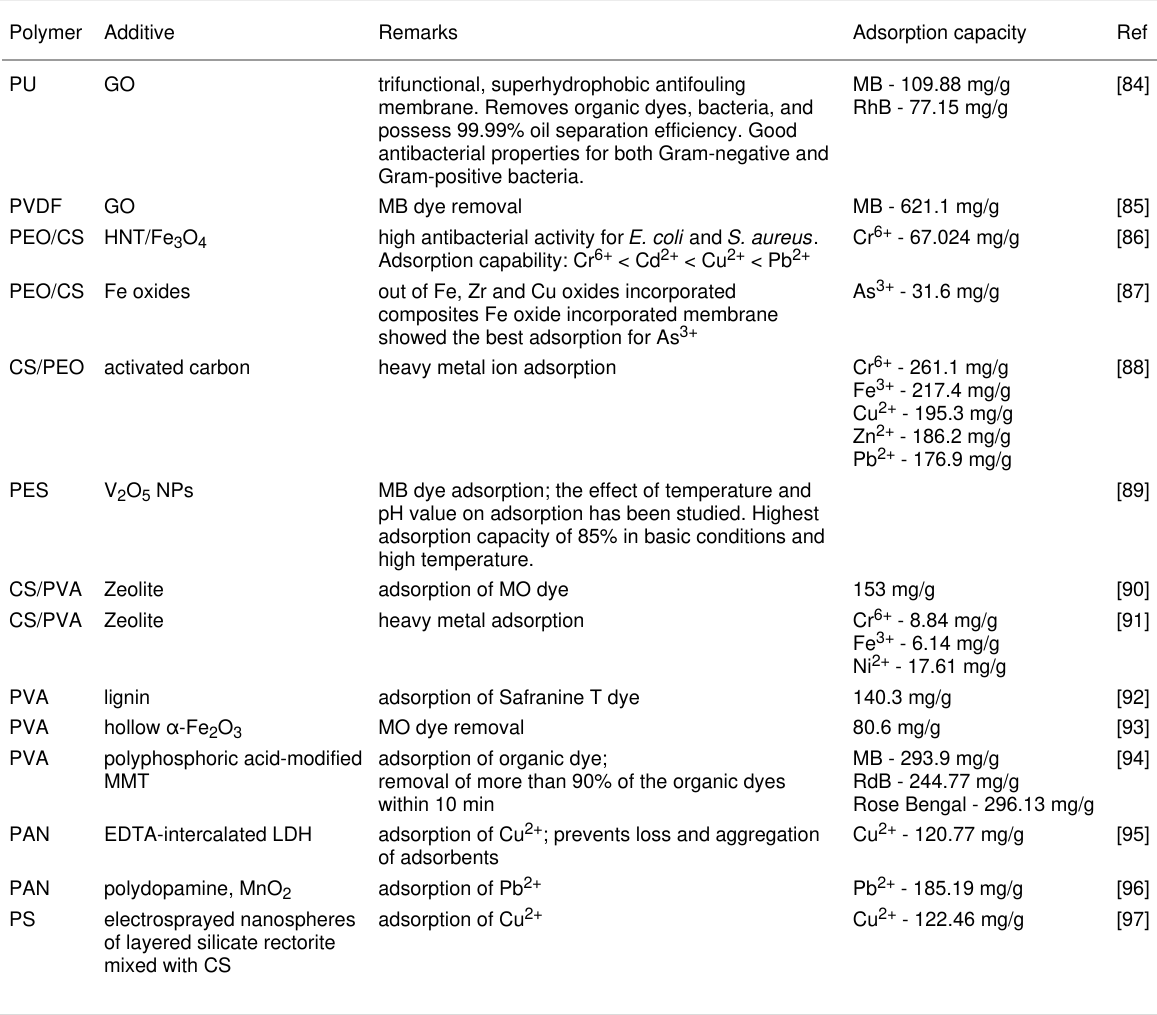
Table 1: Recent advances in electrospun nanohybrid membranes as adsorption membranes in water treatment/purification. Polymer